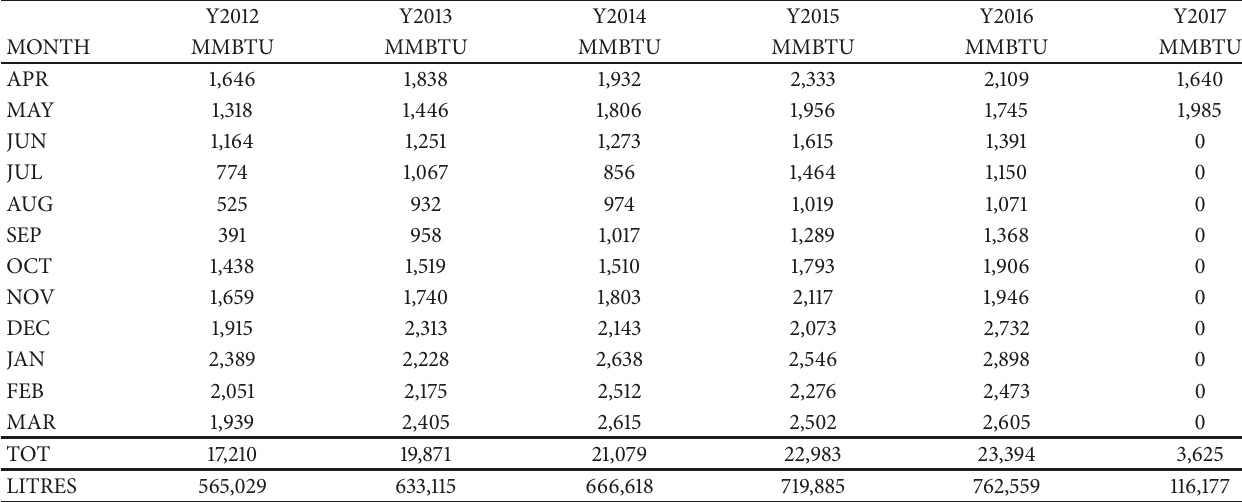
Table 3: Energy from hot water consumption.